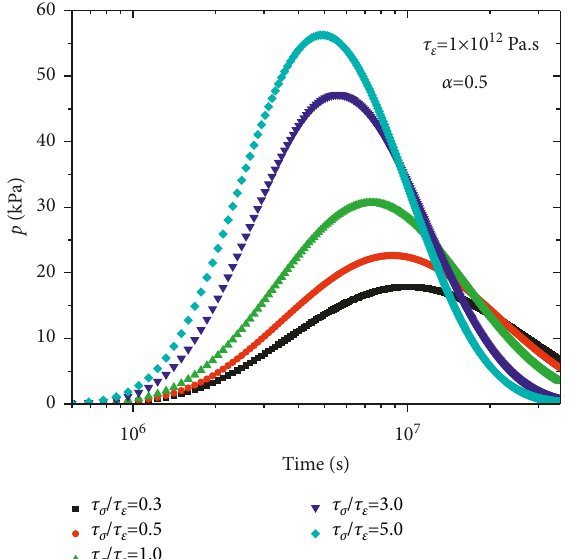
Figure 9: Influence of the material parameter τ